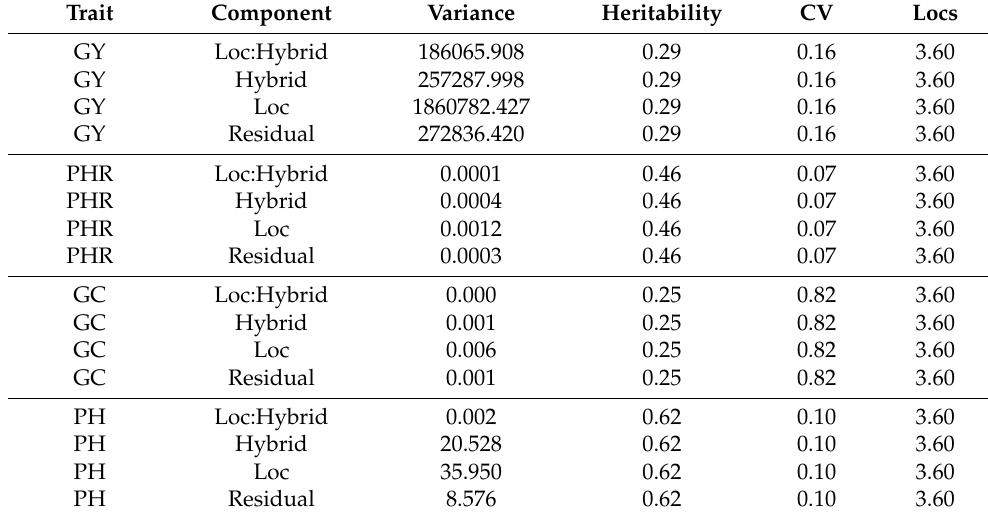
Table 3. Variance components (variance) and heritability’s estimates for Japonica ( dataset 2 ) for each trait. CV denotes the coefficient of variation, and Locs denotes the average number of locations. Trait Component Variance